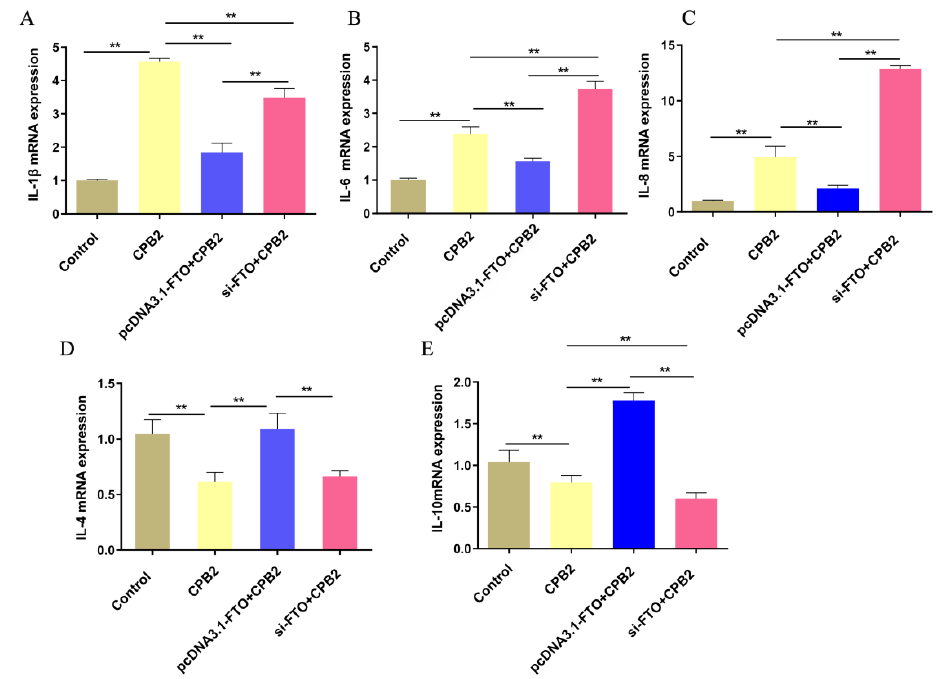
Figure 4. The effect of FTO overexpression or silencing on inflammatory factor expression. ( A – E ) IL-1 β , IL-6 , IL-8 , IL-4 , and IL-10 mRNA levels in IPEC-J2 cells after treatment with 20 μ g/mL CPB2 for 24 h. ** p < 0.01.